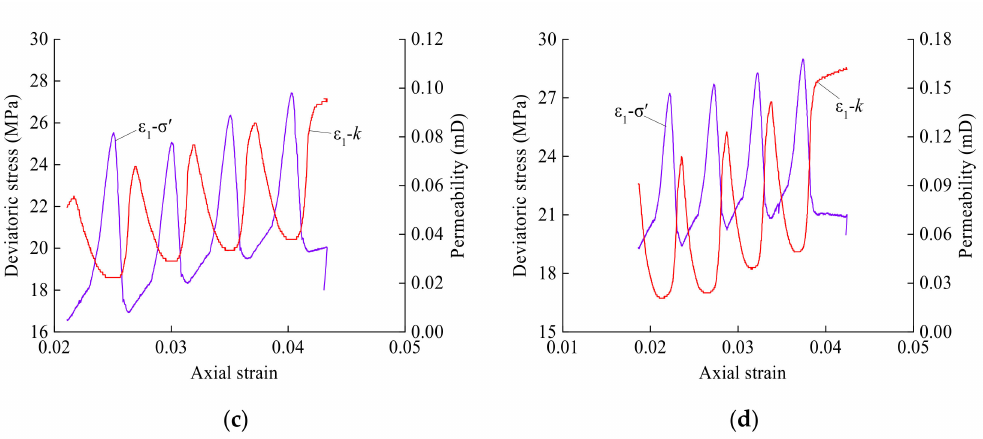
Figure 7. Post-peak deviatoric stress–strain-permeability curves. ( a ) water content 0% ( b ) water content 0.15% ( c ) water content 0.32% ( d ) water content 0.65%.